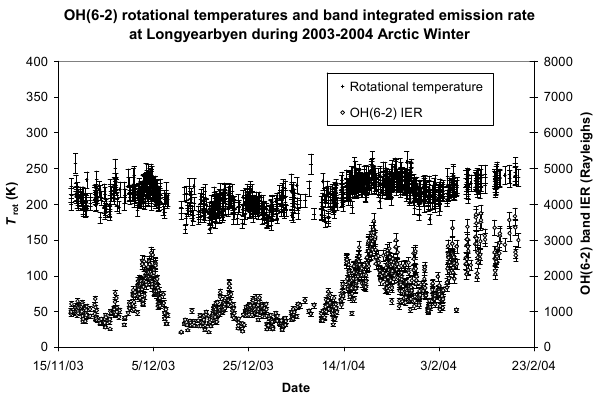
Fig. 4. OH(6-2) rotational temperatures and OH(6-2) inte- grated emission rates measured by the Ebert-Fastie spectrometer at Longyearbyen during the 2003–2004 Arctic winter